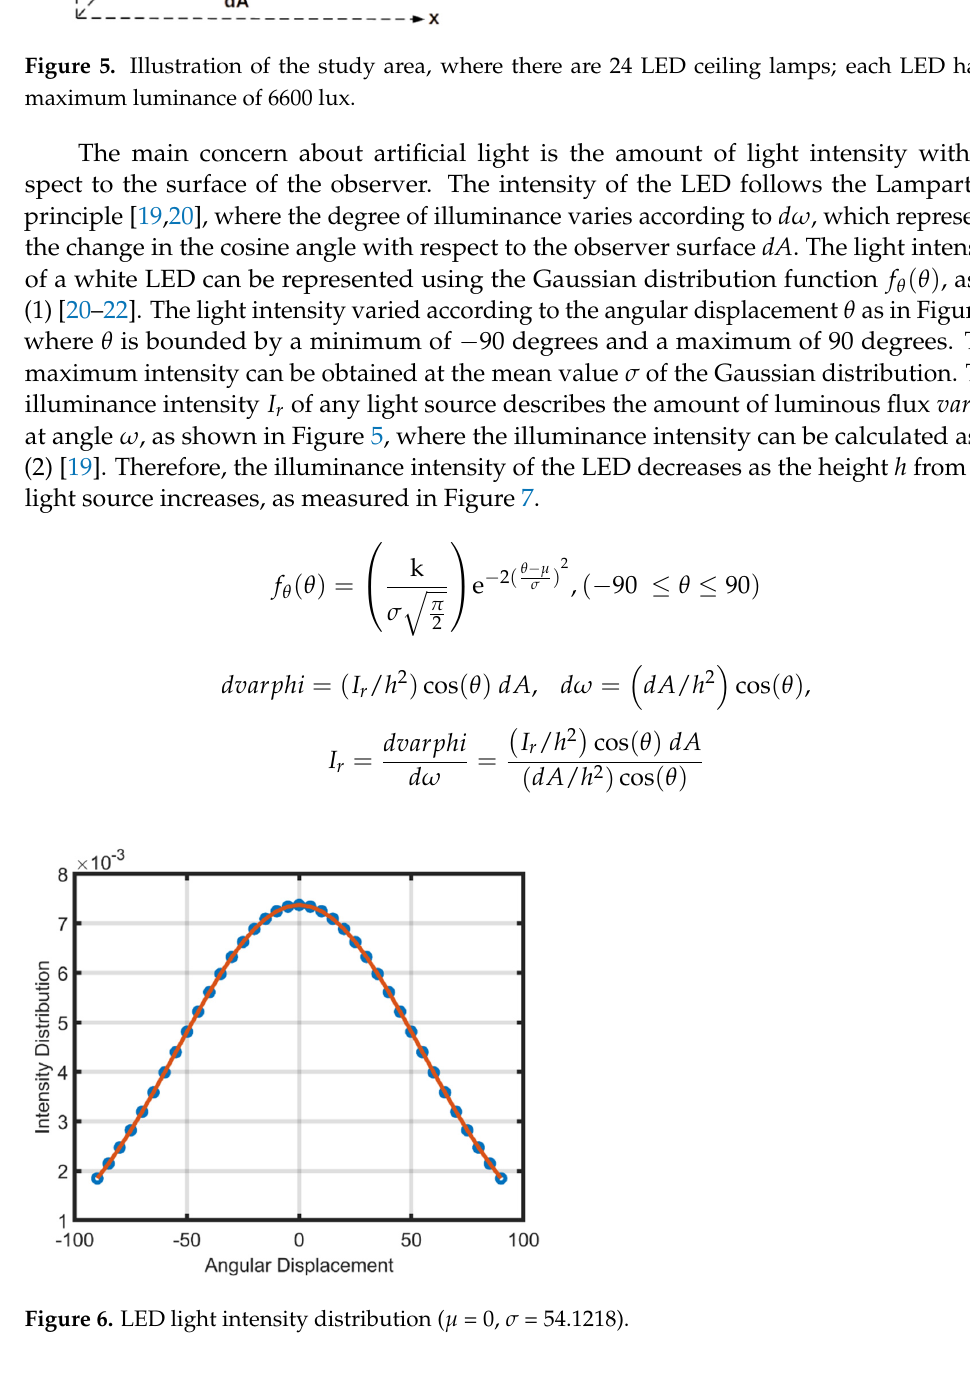
Figure 7. The measured relation between luminance intensity and height. The illuminance intensity formula can be converted into the cartesian coordination where the illuminance at any point P(x,y,z) can be obtained as in (3) where (X, Y, Z) rep- resent the global coordination with respect to the light source. The equation to obtain the total illuminance from the LED matrix at any point in the surface can be represented in (4) [23].